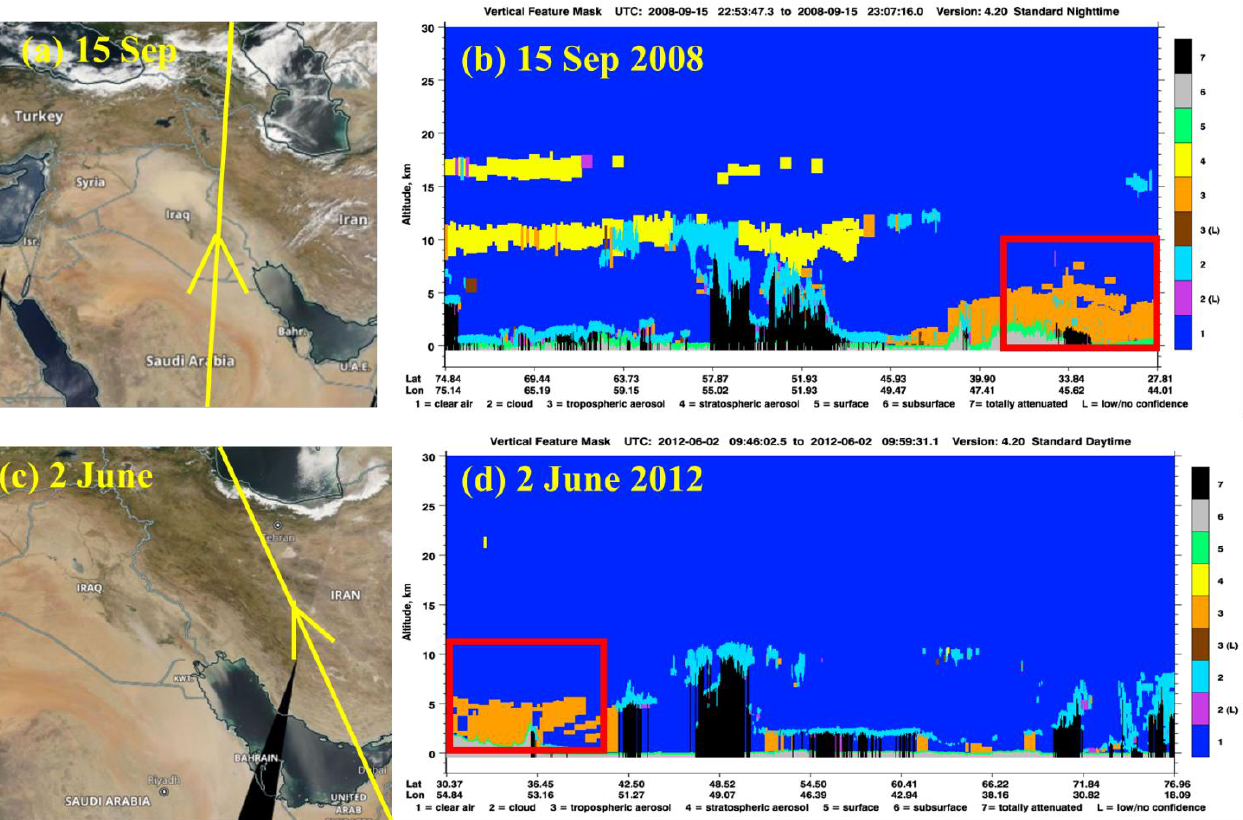
Figure 10. True color imagery from aqua/moderate-resolution imaging spectroradiometer (MODIS) and aerosol-type classification during the two dust storms from CALIPSO. The satellite orbit paths are shown by the yellow lines in the MODIS imagery.